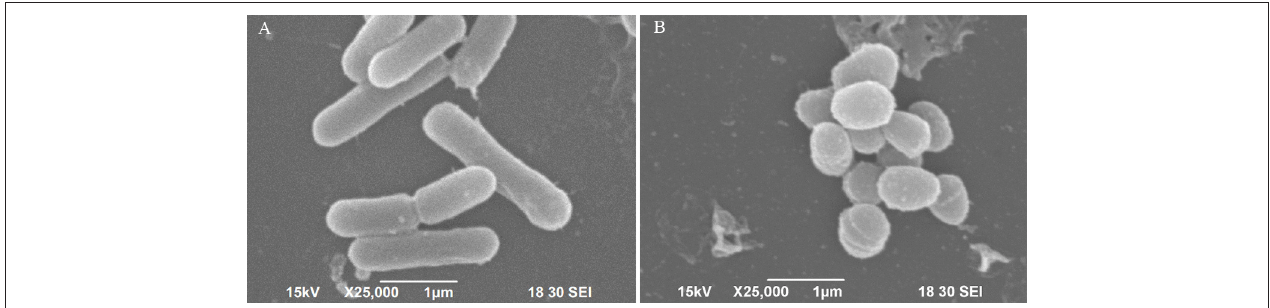
FIGURE 1 | Morphological changes of V. anguillarum cells after starvation revealed by scanning electronic microscopy. (A) Initial cells, (B) 6-months starved cells.